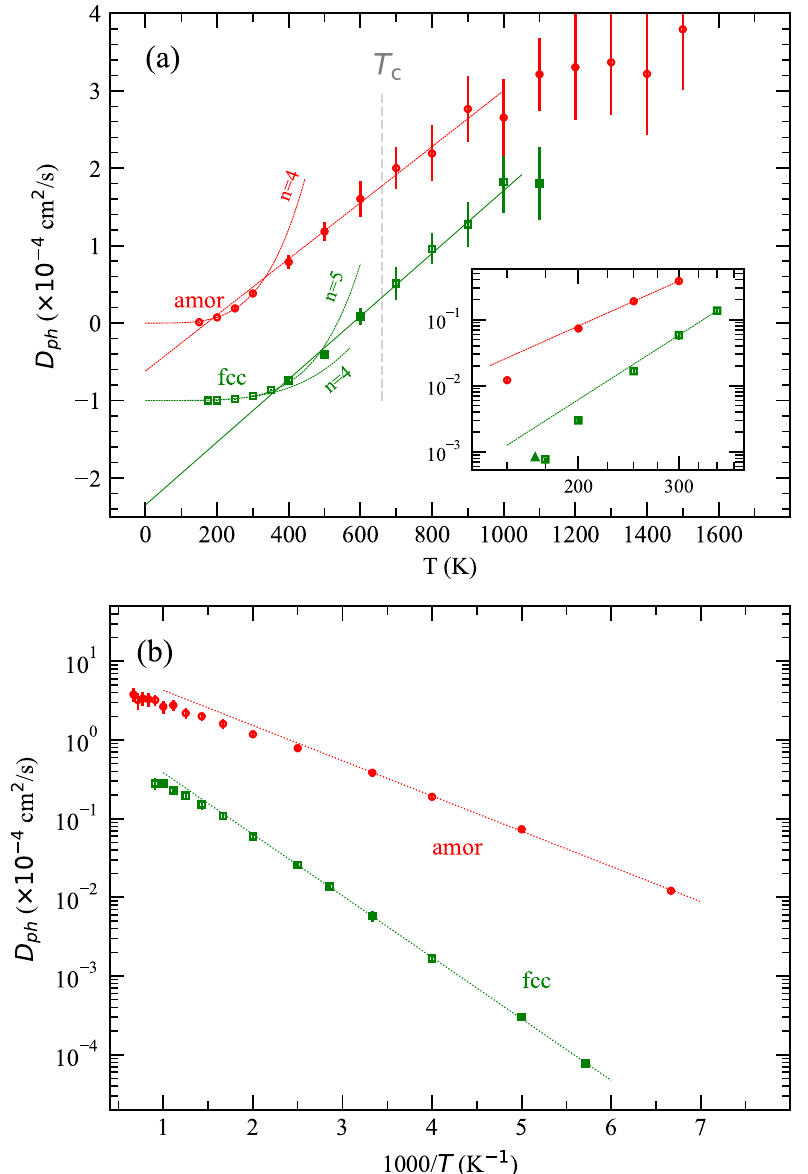
Figure 2. Contribution of Pd phonons to H interstitial diffusion. The data points for the amorphous phase above T c are shown only for reference. ( a ) The linear parts can be fitted with D ph = (4.06 × 10 − 4 3 T − 0.62 4 2 2 ) × 10 − cm /s and (3.62 × 10 − ) × 10 − cm /s for the fcc and amorphous phases, respectively. Power 4 × 10 − 16 5 × 10 − 18 2 2 functions D ph = 6.42 T cm /s and 2.27 T cm /s were used to fit the fcc phase, and D ph 4 × 10 − 15 2 = 4.74 T cm /s was used for the amorphous phase. The plotted data for the fcc phase are shifted downwards for clarity. Inset: Zoom-in for low temperatures in log scales, same units as in the main. The linear lines are for eye guide only. The triangle indicates the upper limit of D ph (by setting D j = 0) of fcc at 175 K (triangle slightly shifted to the left for clarity). ( b ) Arrhenius plot of D ph